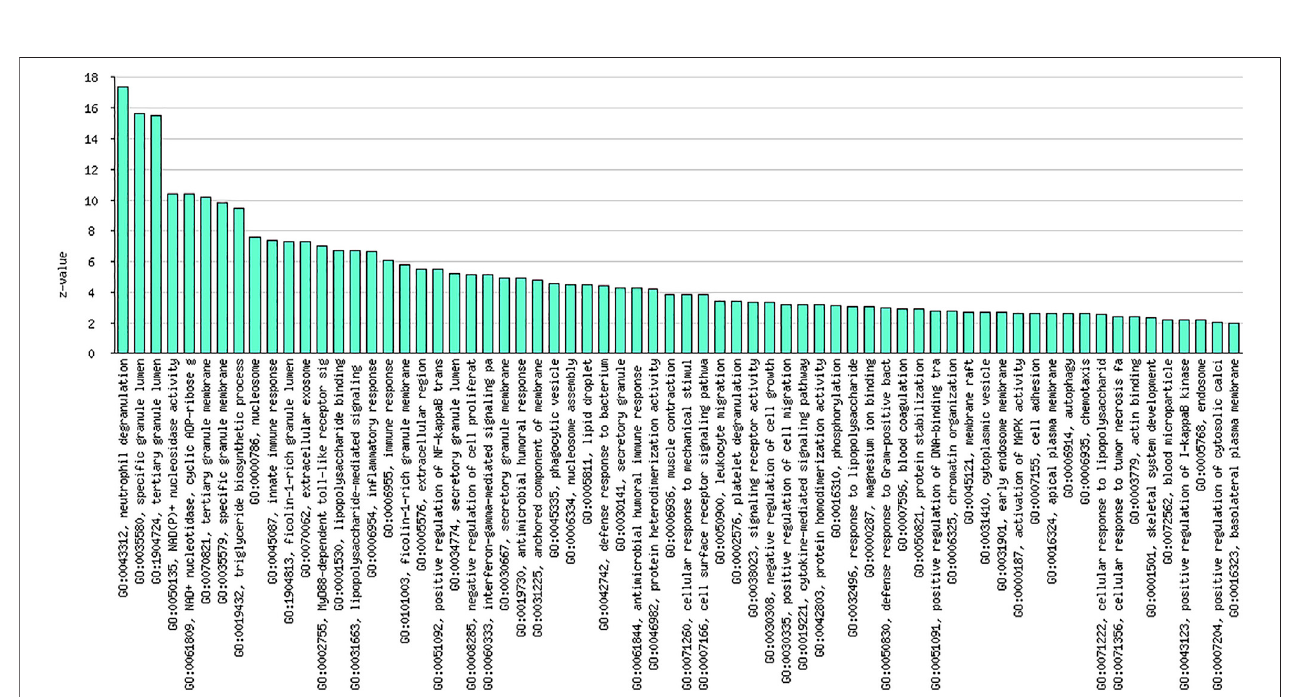
FIGURE 3 | Graphical representation of signi fi cantly overrepresented individual categories of GO molecular function for the upregulated genes.